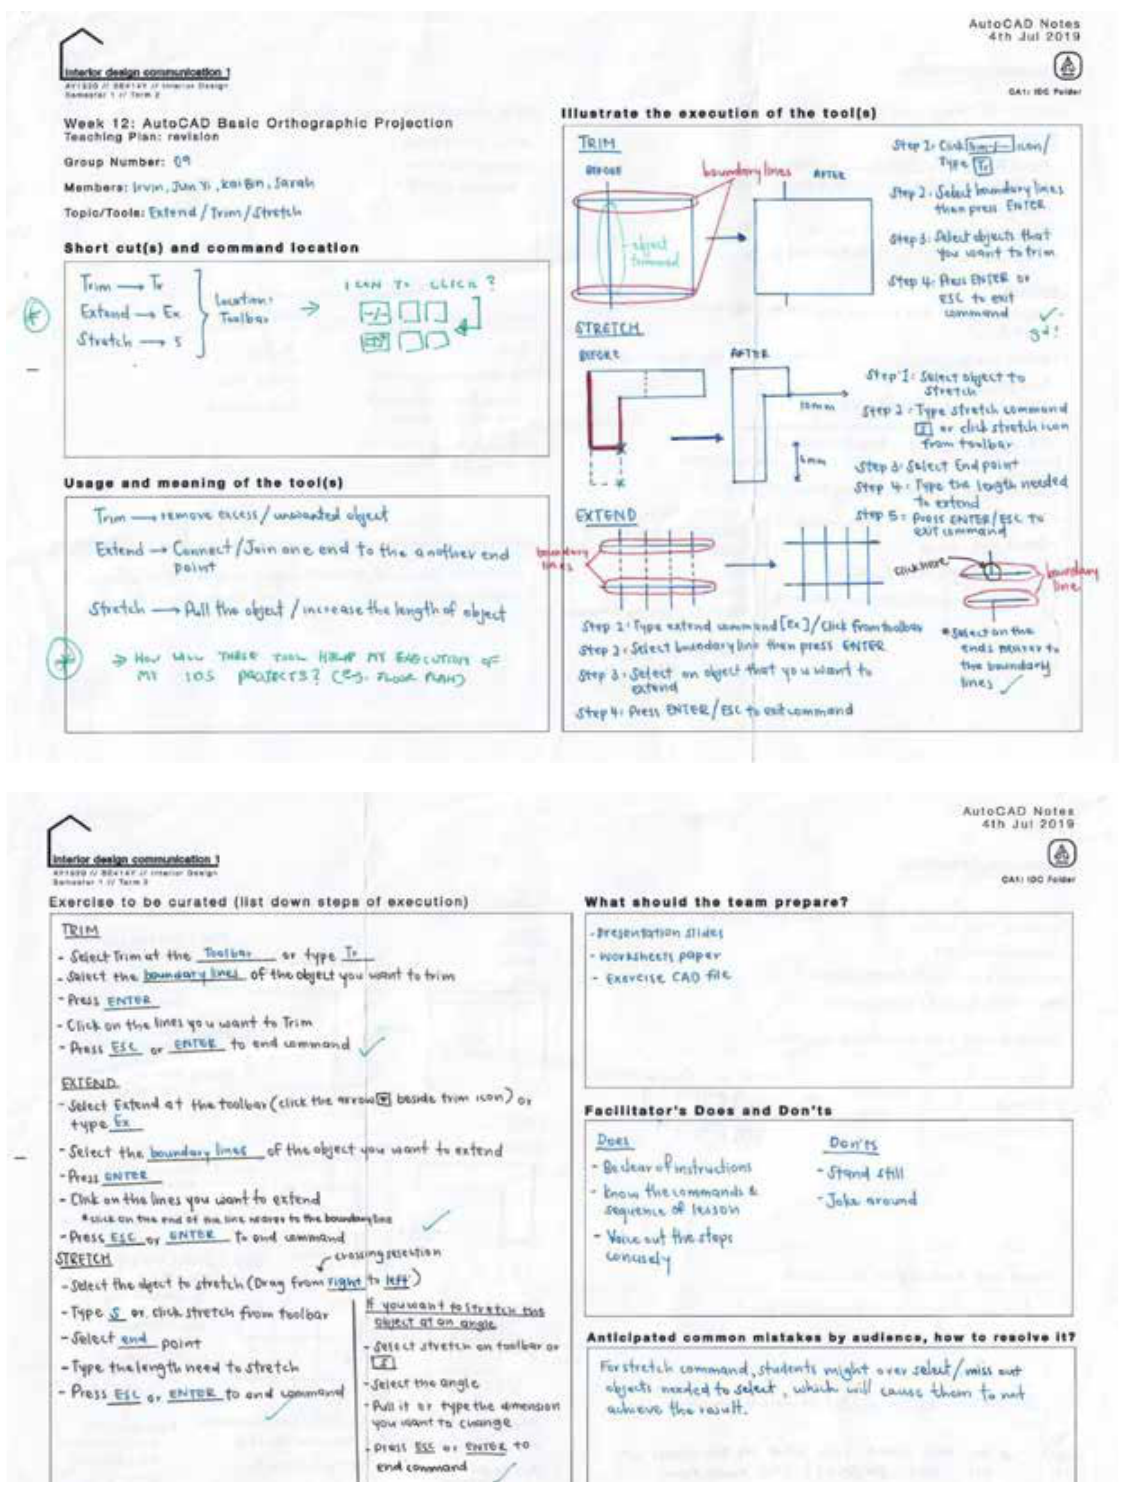
Figure 7: Sample team worksheets. Source: